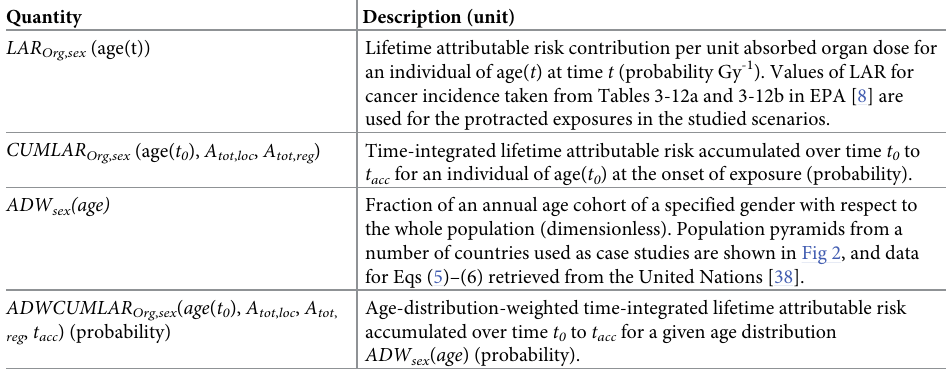
Table 4. Quantities defined in Eqs (3)–(5)used for the evaluation of time-integrated (cumulative) lifetime attrib- utable risk